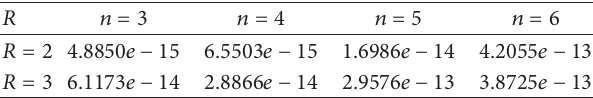
Table 6: Error 𝜀 of Example 2 for different 𝑅 .